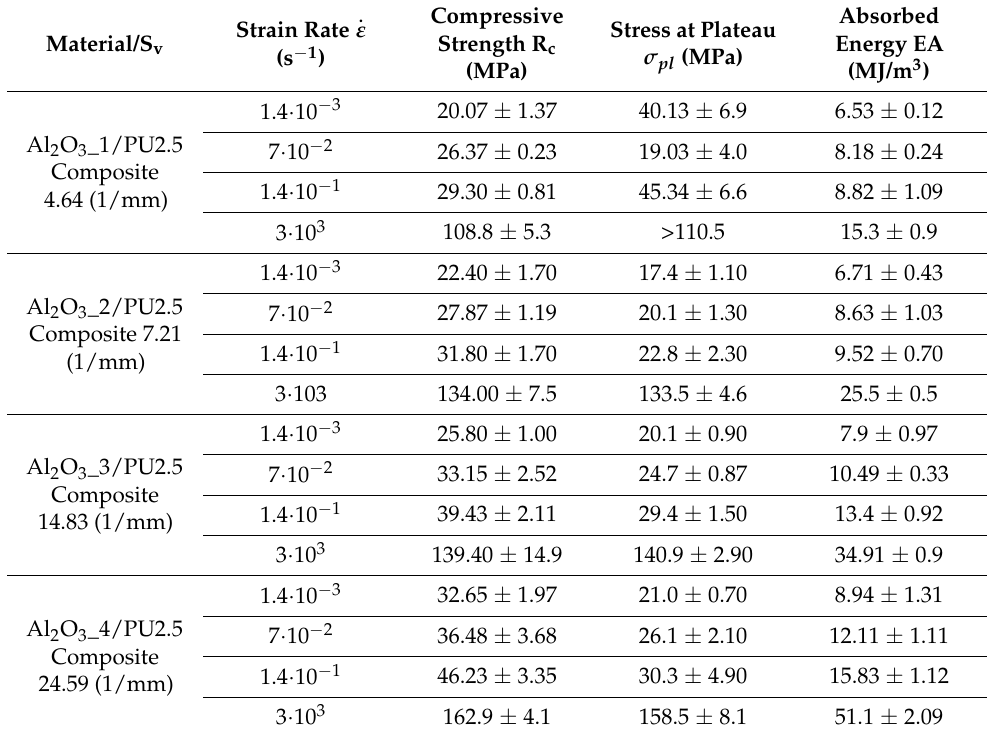
Table 2. Mechanical properties of composites determined during static and dynamic compressive